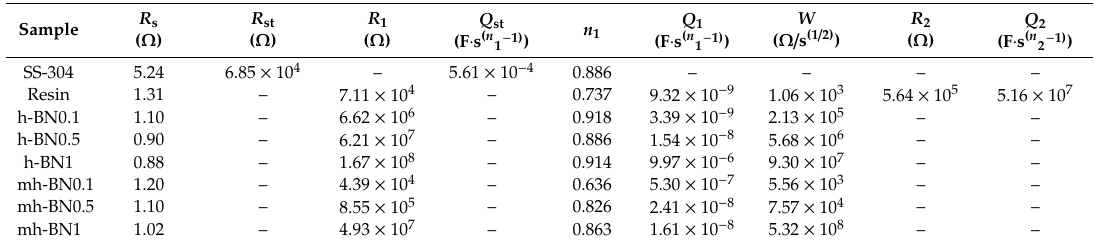
Figure 9. Electrochemical corrosion models: ( a ) SS-304, ( b ) acrylic coating and ( c ) nanostructured coatings. Table 4. Electrical equivalent circuit parameters of the acrylic resin and the formulations with unmodified (h-BN) and modified treated (mh-BN)